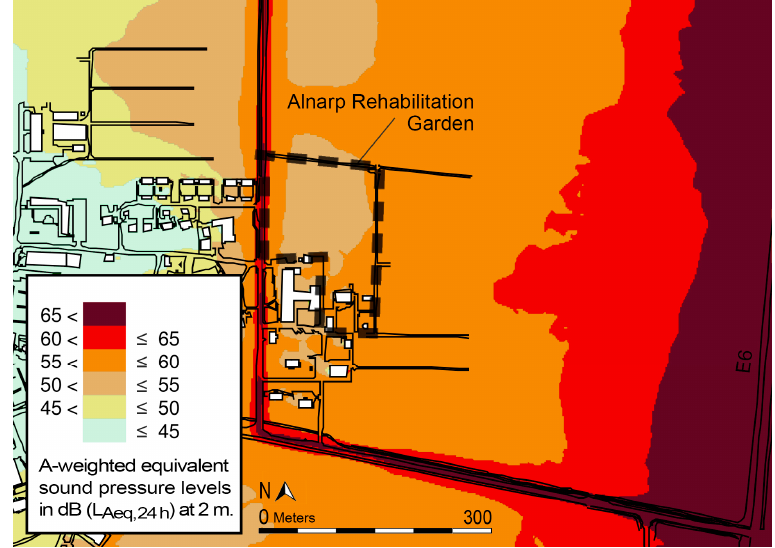
Figure 2. Noise map, illustrating A-weighted equivalent sound pressure levels in dB (L Aeq, 24 h ), in and around the garden. Calculations are for 2 m above ground level and include all state- and municipal roads. The map was extracted from a noise survey commissioned by the Lomma municipality